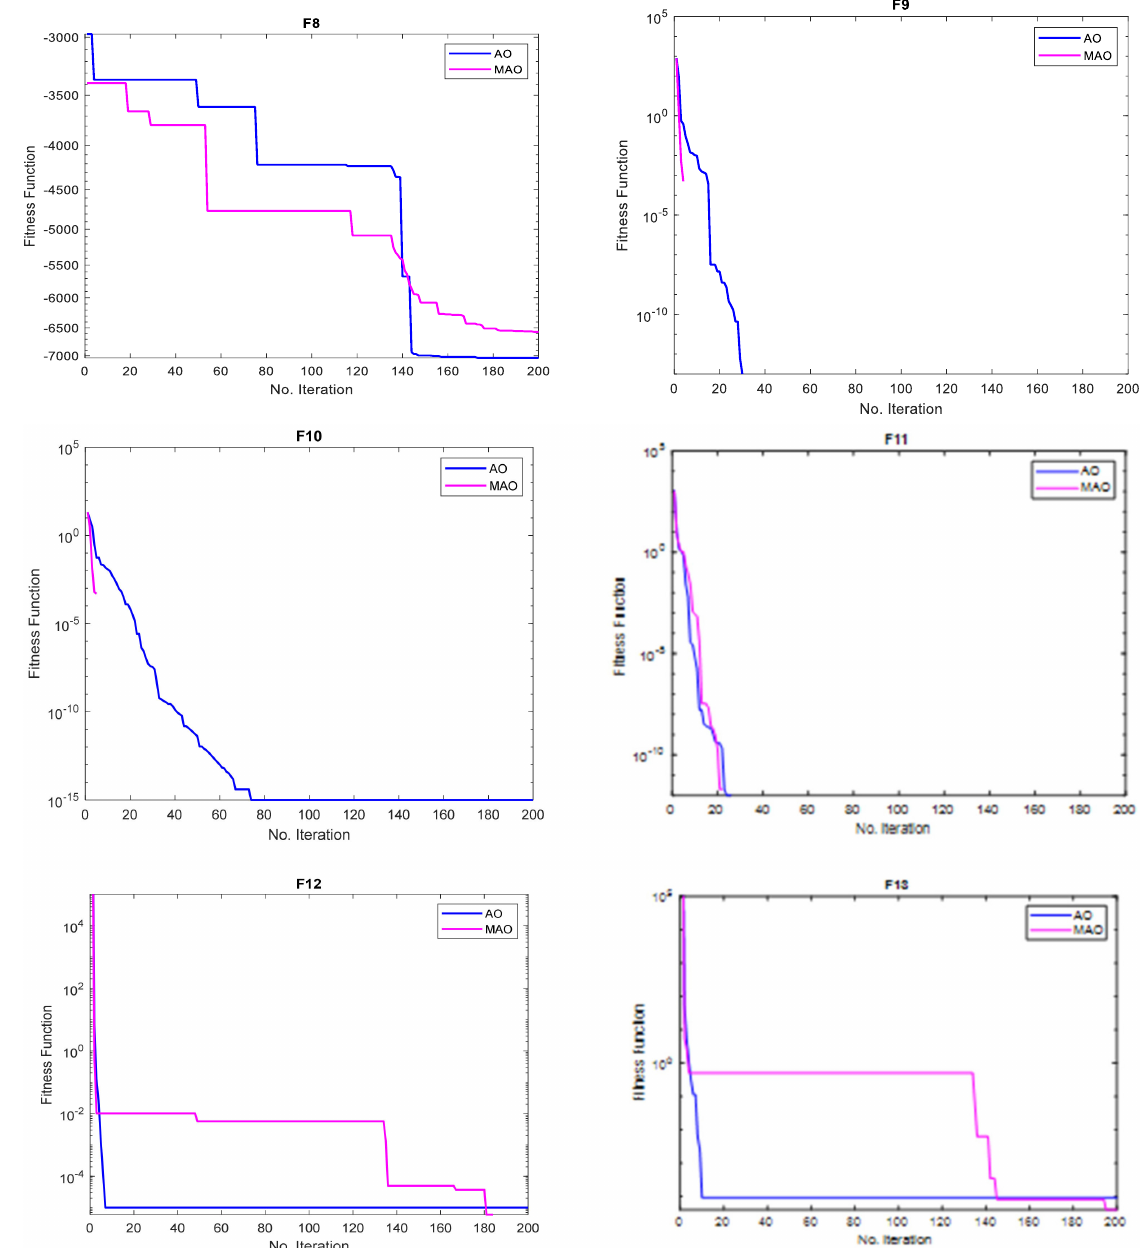
Figure 6. Convergence analysis of multimodal benchmark functions with D =